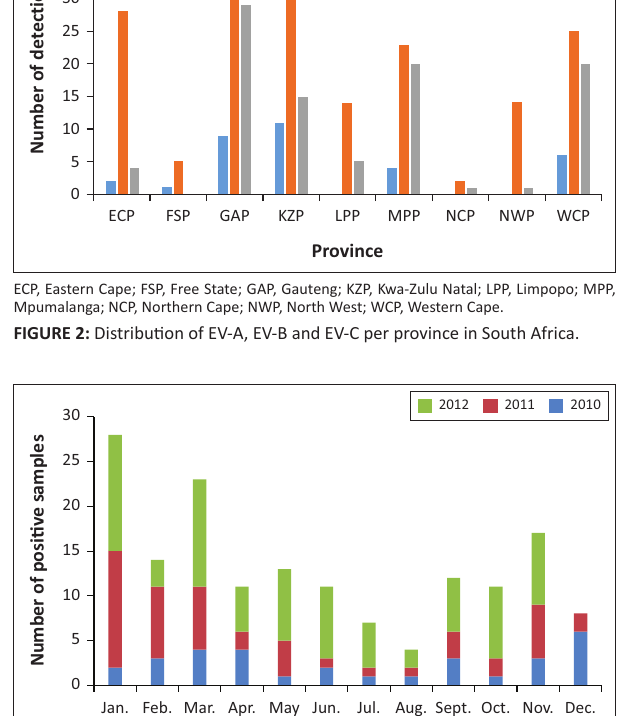
Jan. Feb. Mar. Apr. May Jun. Jul. Aug. Sept. Oct. Nov.